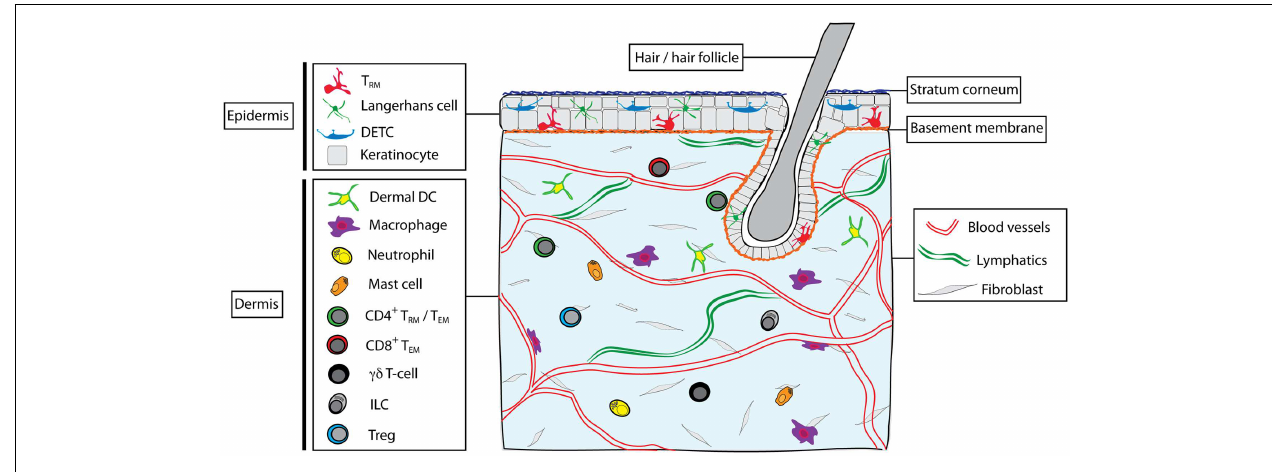
skin, including Langerhans cells, dendritic epidermal γδ T cells (DETC), and memory αβ T cells (T RM ) in the epidermis. In the steady state, the dermis contains a heterogeneous mix of immune cells, including subsets of dendritic cells (including CD11b + and CD103 + DC), macrophages (including dermal and perivascular macrophages), neutrophils, mast cells, γδ T cells, ILC, CD4 + T cells (bothT EM and possibly T RM subsets),T regulatory cells (Treg), and CD8 + T EM